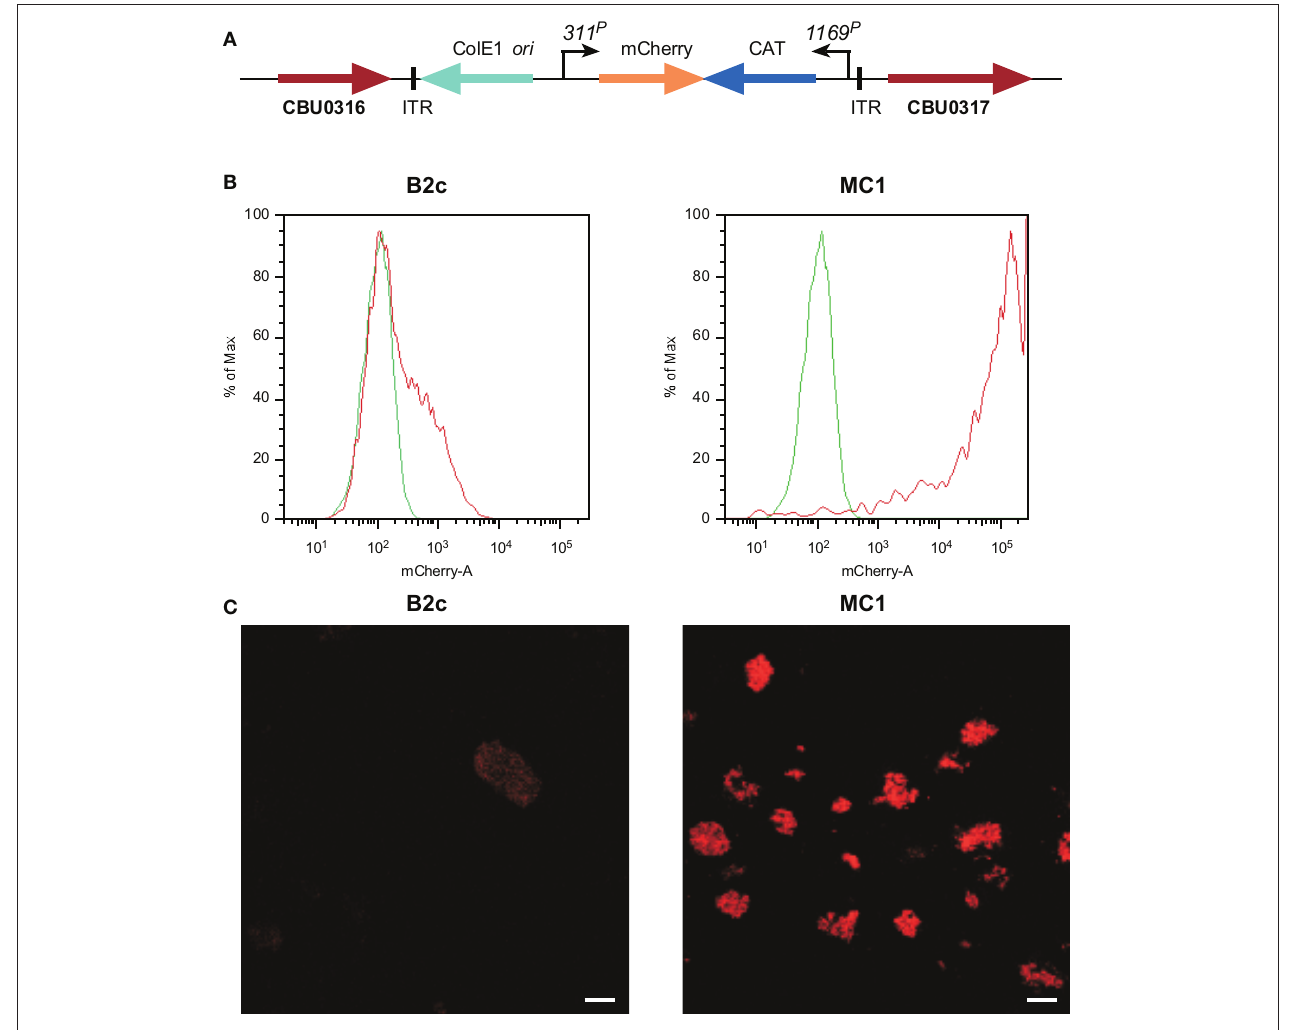
5 days. Both assays revealed considerably more mCherry fluorescence from MC1-containing vacuoles, where expression is driven by 311 P , then from B2c-containing vacuoles, where expression is driven by 1169 P (Beare et al., 2009). The green trace in flow cytometry histograms shows autofluorescence of Vero cells infected with wild-type C. burnetii for 5 days. Bars, 5